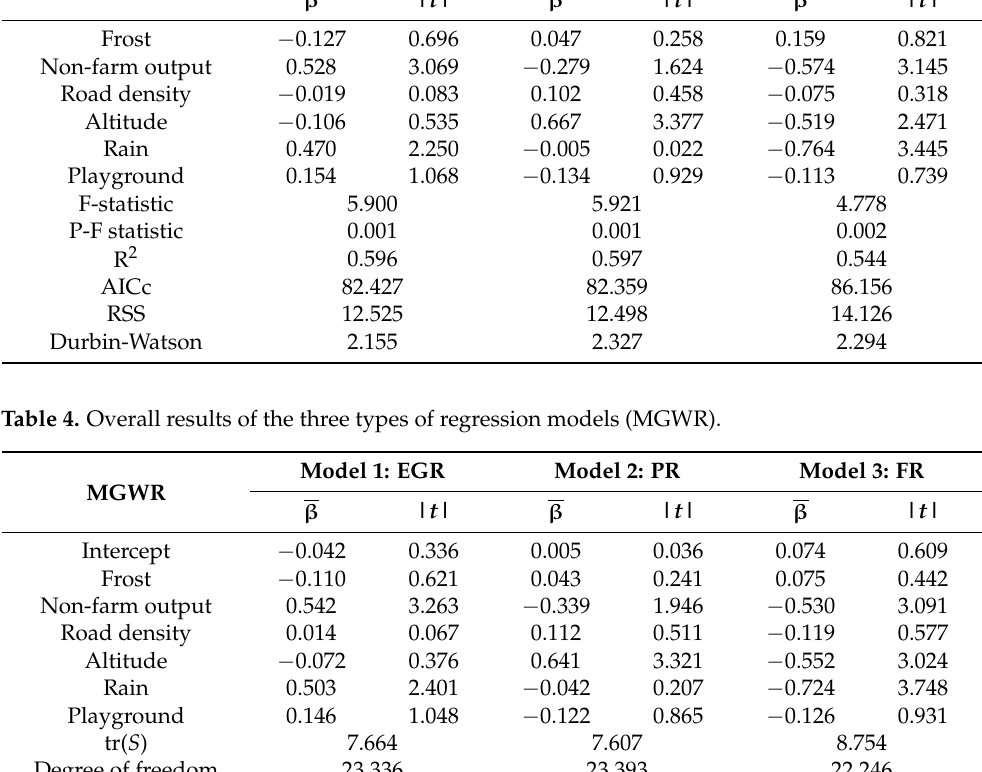
Table 3. Overall results of the three types of regression models (OLS). OLS